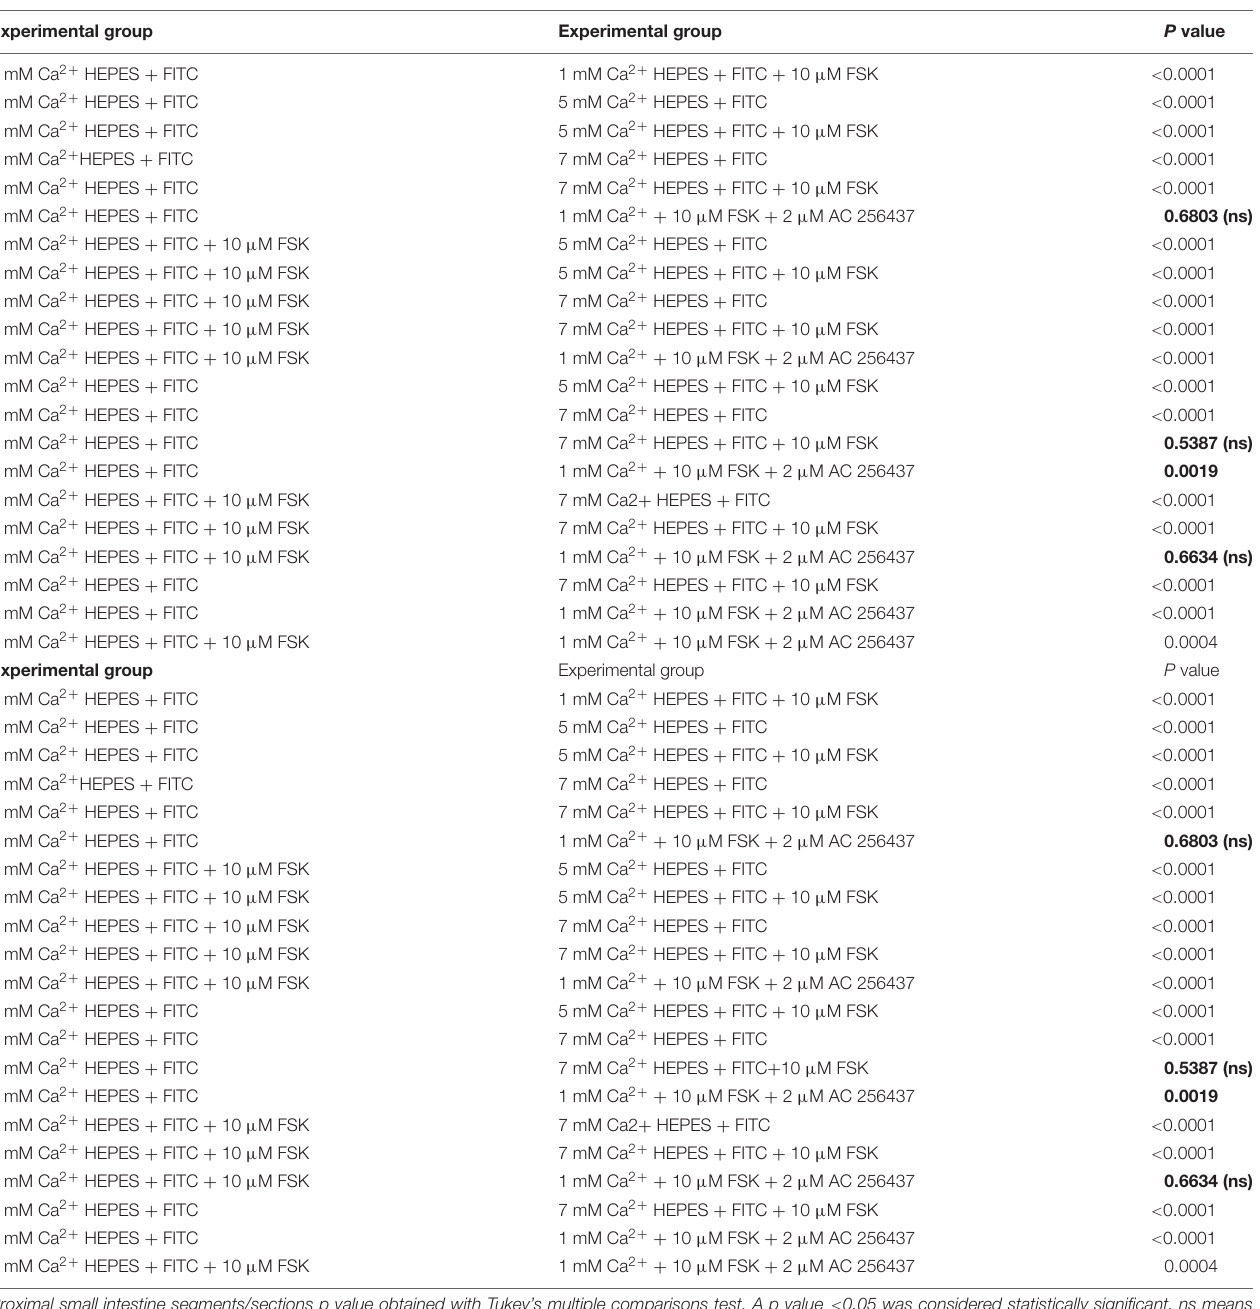
TABLE 4 | Proximal region of small intestine. P values of (cid:49) Fluorescence/Minute with the different [Ca 2 + ] and FSK in comparison to AC-265347 with FSK. Experimental group Experimental group P